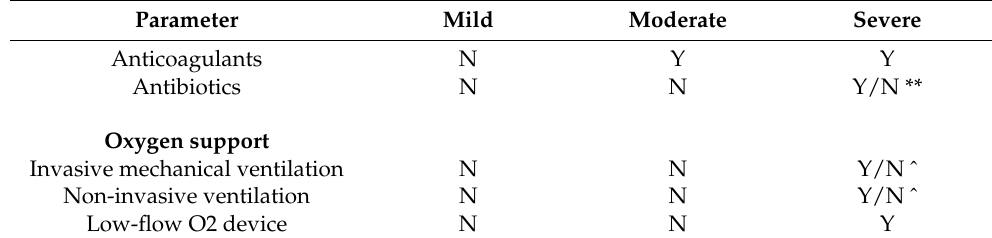
Table 1. Cont. Parameter Mild Moderate Severe Anticoagulants N Y Y Antibiotics N N Y/N ** Oxygen support Invasive mechanical ventilation N N Y/N ˆ Non-invasive ventilation N N Y/N ˆ Low-flow O2 device N N